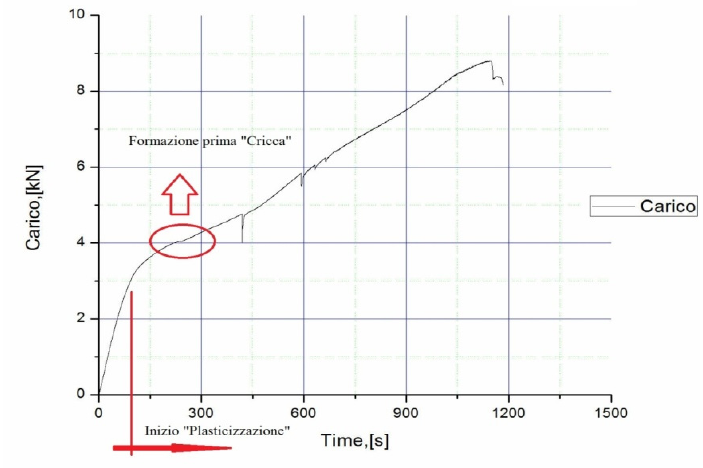
Figura 10: Prove statiche su componenti del secondo tipo.